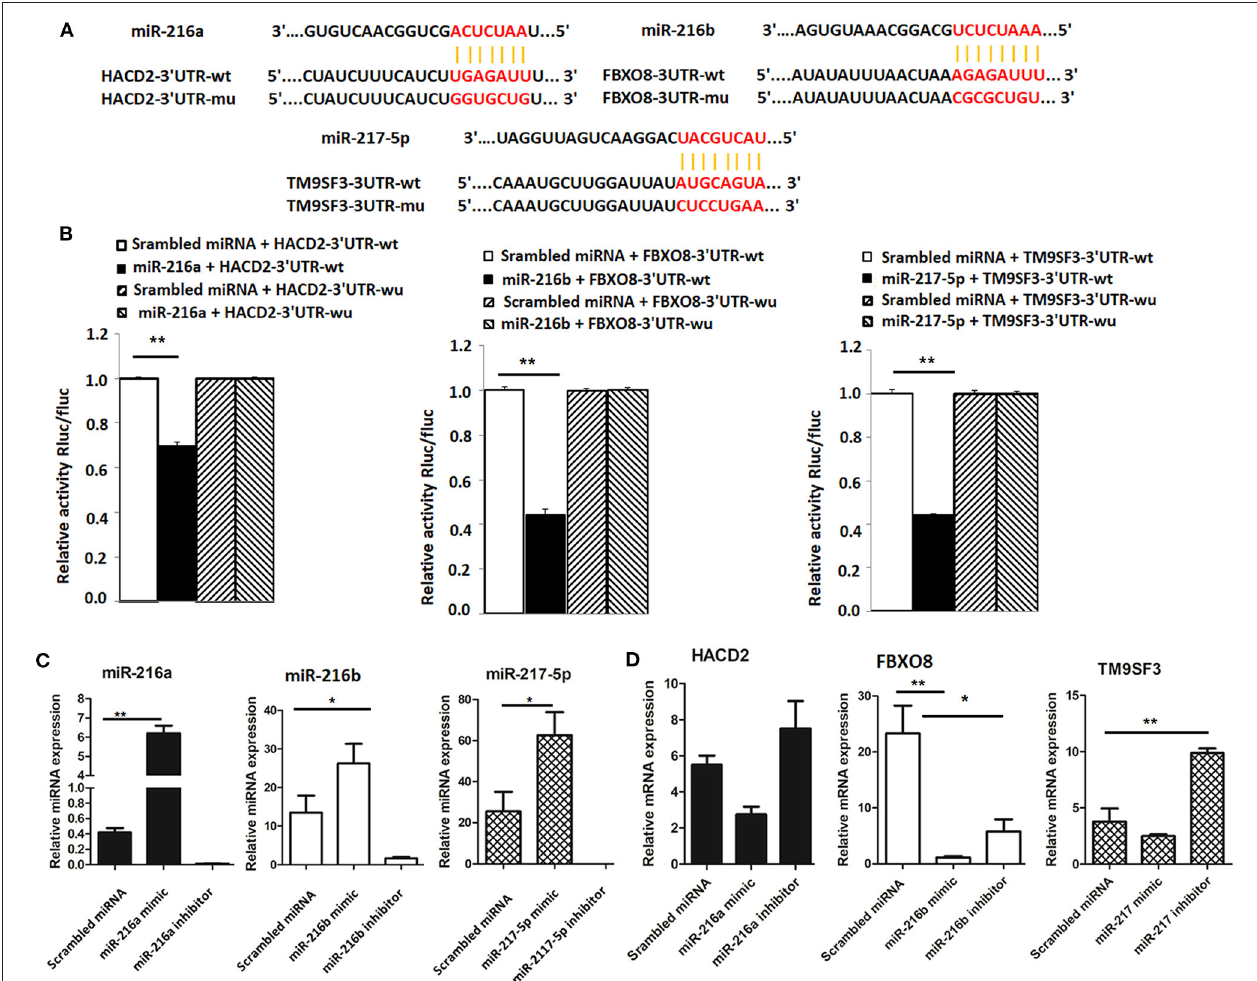
FIGURE 4 | Validation of targets of the miR-216/miR-217 cluster (A) Wild-type and mutant sequences of HACD2 , FBXO8 , and TM9SF3 (B) results of the dual luciferase reporter gene assay. (C) Expression of miR-216/miR-217 cluster members in LMH cells after up-regulation or down-regulation of the miR-216/miR-217 cluster. (D) mRNA levels of targets after up-regulation or down-regulation of the miR-216/miR-217 cluster. * P < 0.05 and ** P <